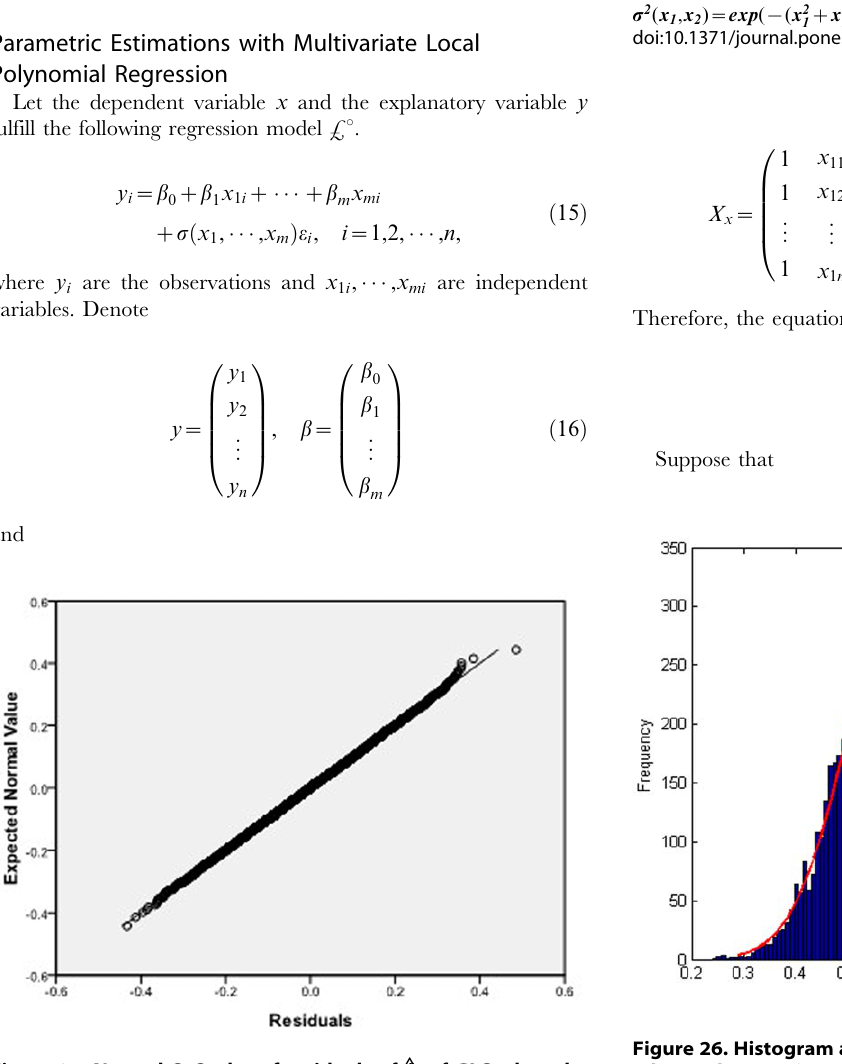
Figure 24. Normal Q-Q plot of residuals of ^ bb 2 of GLS when the variance function of the error term is s 2 ( x 1 , x 2 ) ~ exp ( { ( x 2